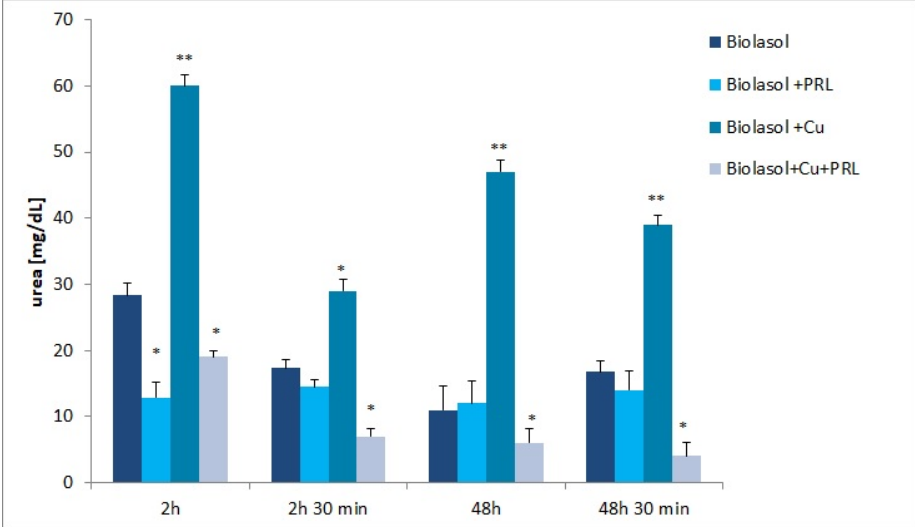
Figure 4. Urea concentration in the perfusate samples collected. The values are expressed as mean ± SEM. Data were analysed by one-way ANOVA and Bonferroni post hoc tests; n = 10; * p < 0.05; ** p < 0.01 compared to the control group (Biolasol).